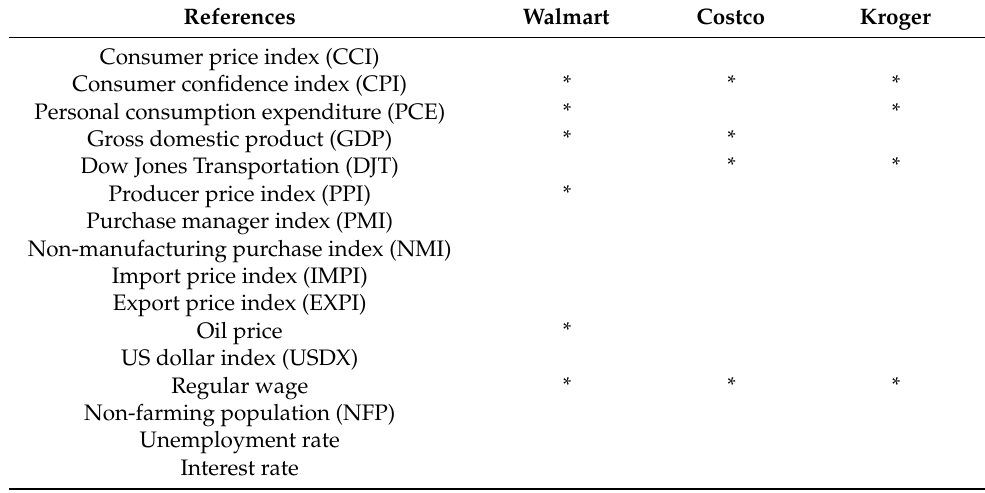
Table 3. Identified economic indicators for the three US retailers using Lasso. * means significant indicators.